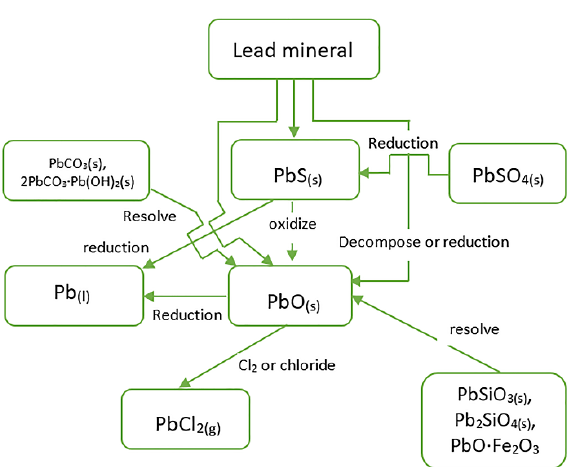
Figure 6. Migration and enrichment changes in the reduction of Pb-bearing minerals.